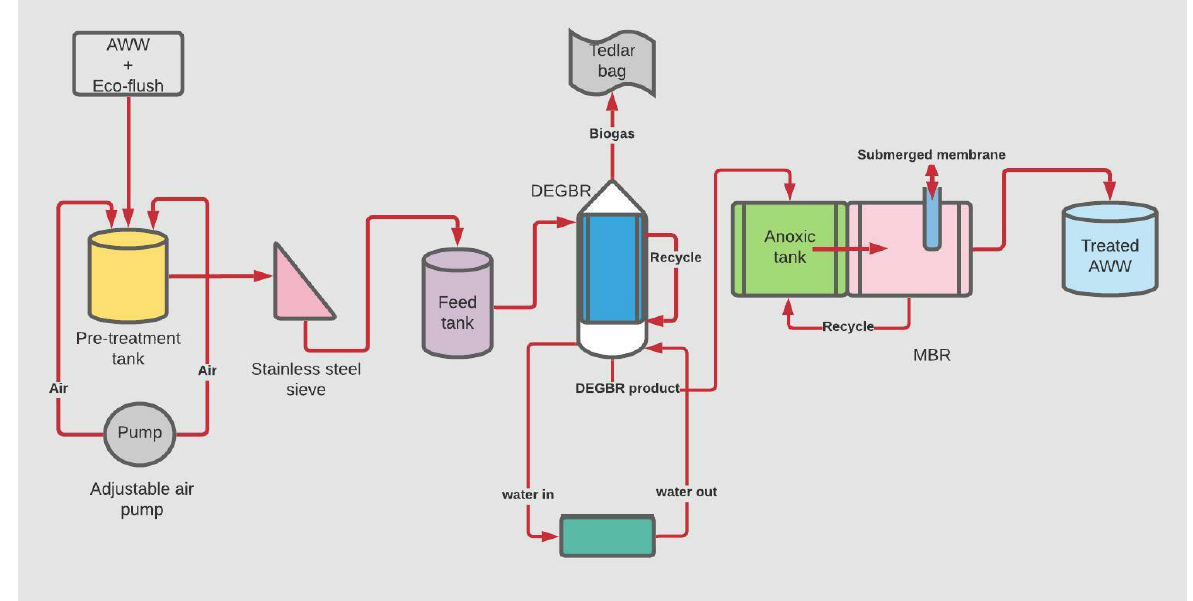
Figure 6. Process flow diagram of a proposed multi-stage integrated system to treat AWW.